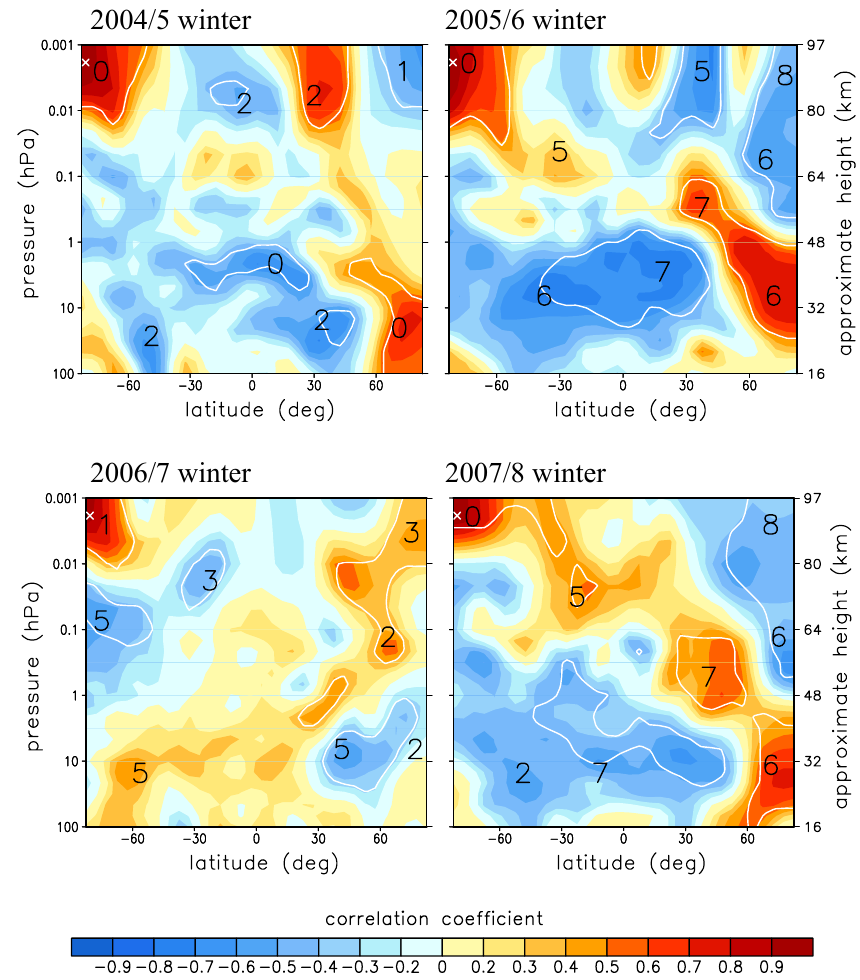
Fig. 12. Similar to Fig. 11, but for the strongest lagged-correlation coefficient over time lags of 0 to 10 days with the detrended time series. The black numbers represent the time lags (unit: day). The Antarctic summer mesopause is the reference point; positive lags mean that the Antarctic mesopause temperature sequence is